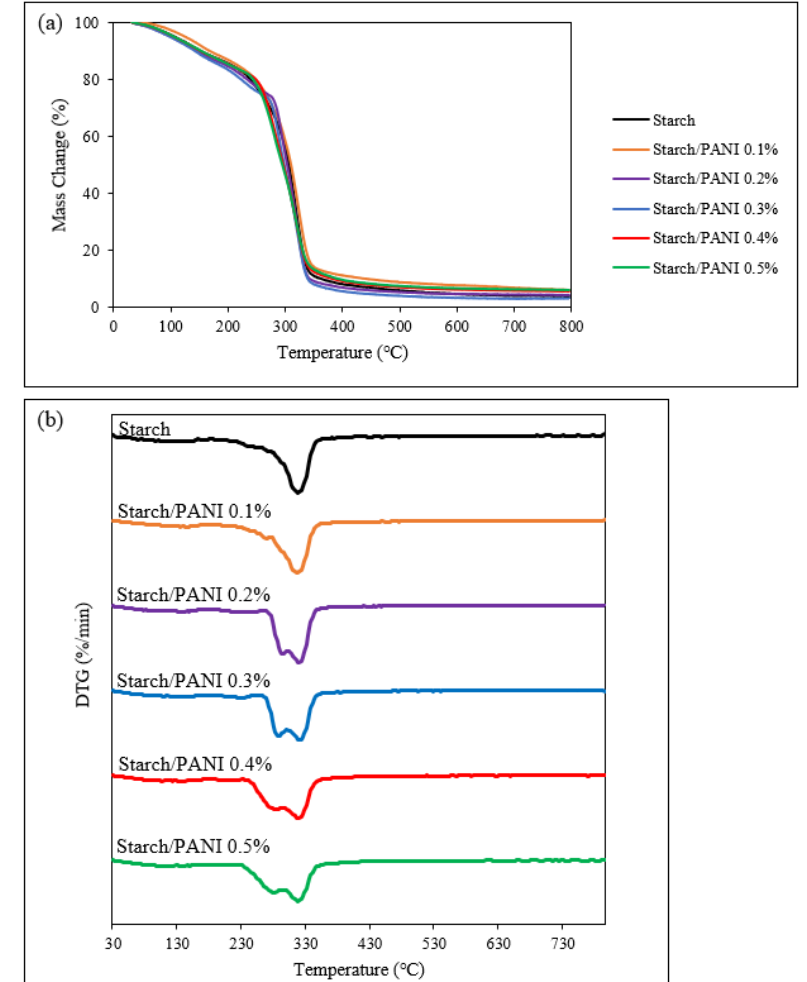
Figure 6. ( a ) TGA and ( b ) DTG thermograms of starch and starch/PANI (0.1%, 0.2%, 0.3%, 0.4%, 0.5%)-polymer films. Table 1. Degradation temperatures of starch and starch/PANI (0.1, 0.2, 0.3, 0.4, 0.5%)-polymer films.